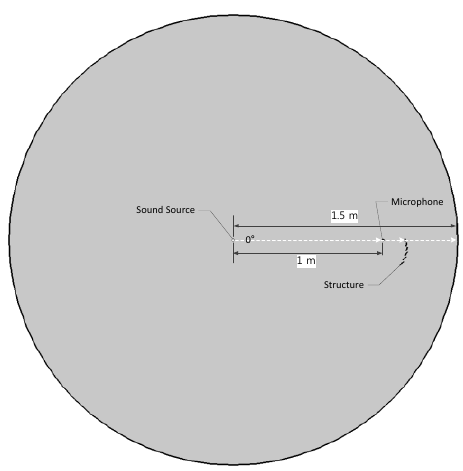
Figure 6. COMSOL simulation geometry for 0° angle of arrival (AoA). The RML structure is located in the air space (circle) with a perfectly absorbing boundary.